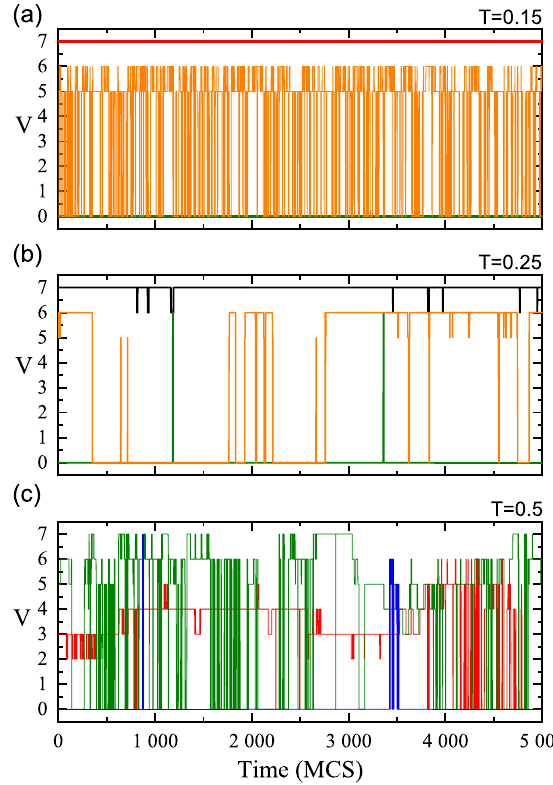
Figure 3. Time-dependence of local free volume V for three representative cells at T = 0.15 ( a ), 0.25 ( b ) and 0.5 ( c ), see text for more